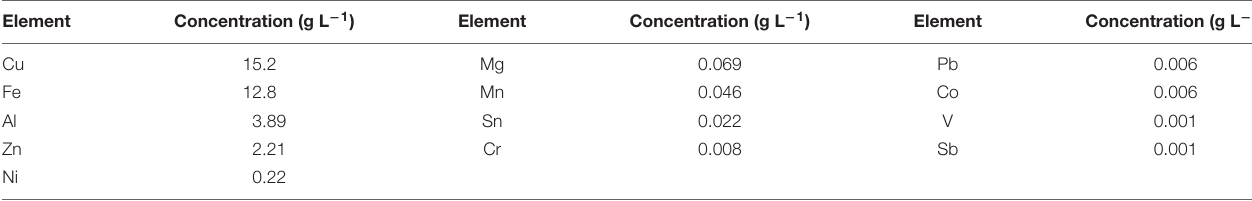
TABLE 2 | Metal concentration of the chemical PCB leachate used to test the microbial performance in shake flasks.